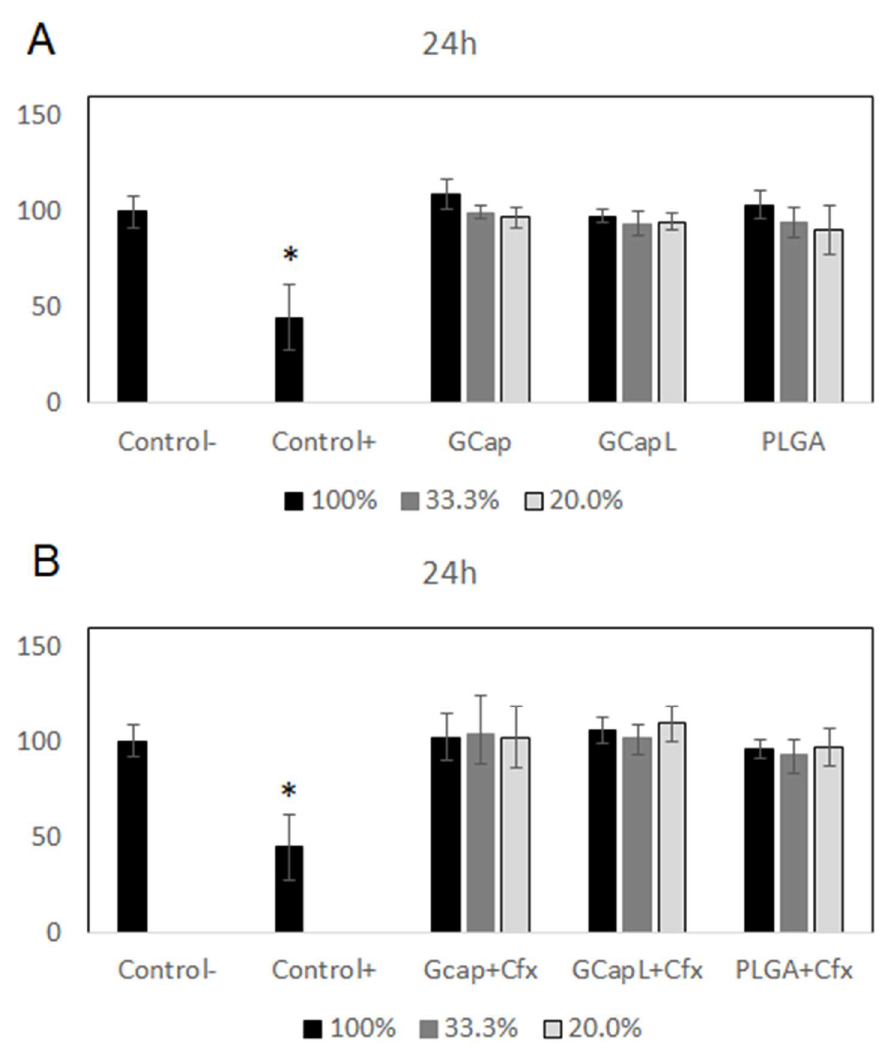
Figure 5. Effect of extracts obtained after 24 h of incubation of the samples with drug-free polymer coatings ( A ) and polymer coatings containing ciprofloxacin ( B ) on the proliferation of cells ( * p < 0.05 versus the control group).